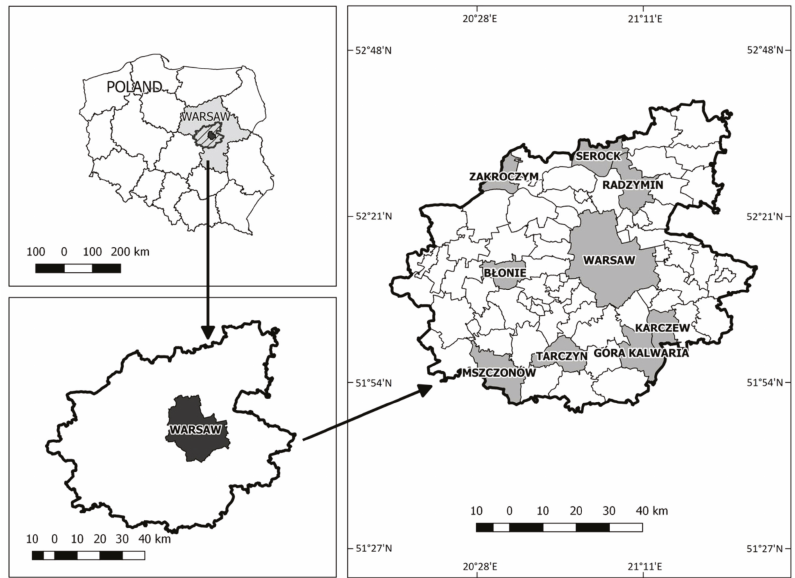
Figure 3. The Warsaw Metropolitan Area (Obszar Metropolitalny Warszawy, OMW) with cities marked for detailed analyses. Source: own